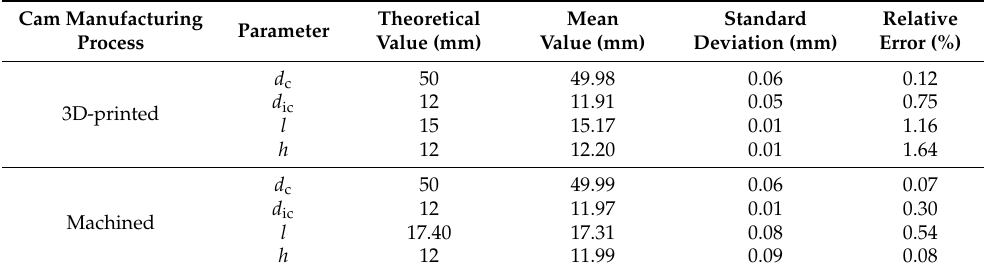
Table 4. Dimensions of the 3D-printed and machined cams.